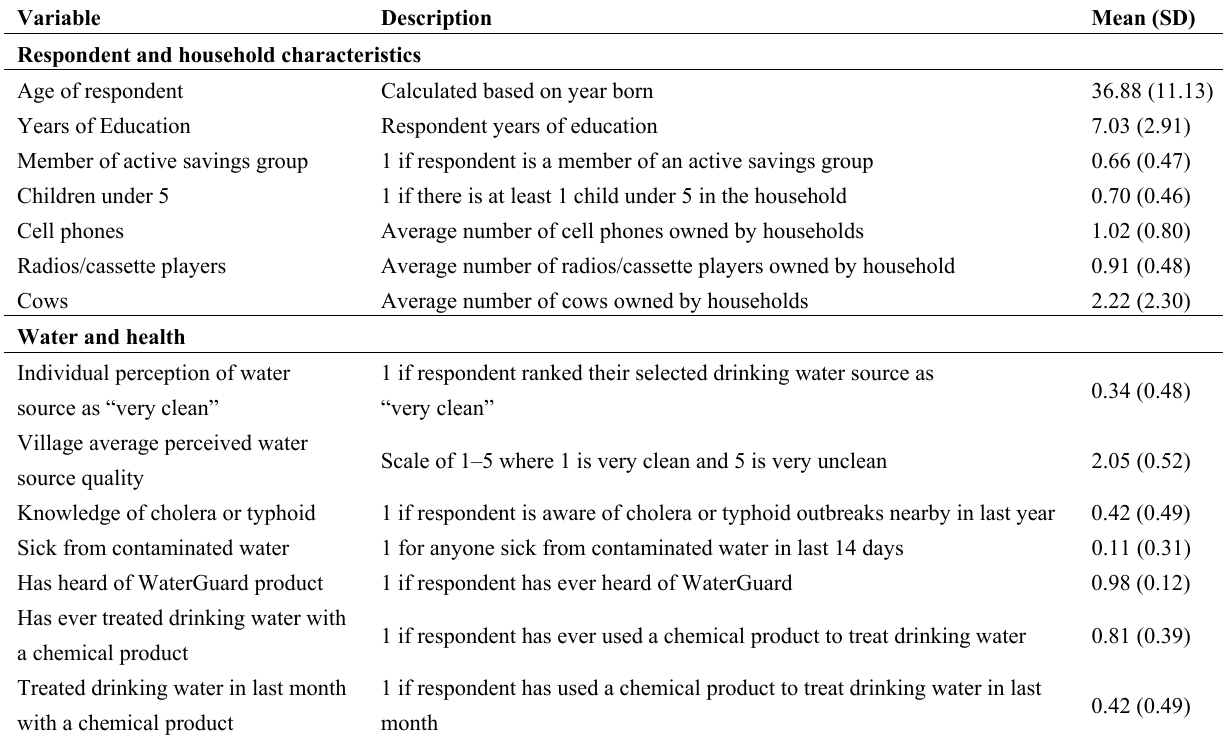
Table 1. Mean and standard deviation of respondent and household characteristics, perceptions of water and health, and water treatment knowledge and